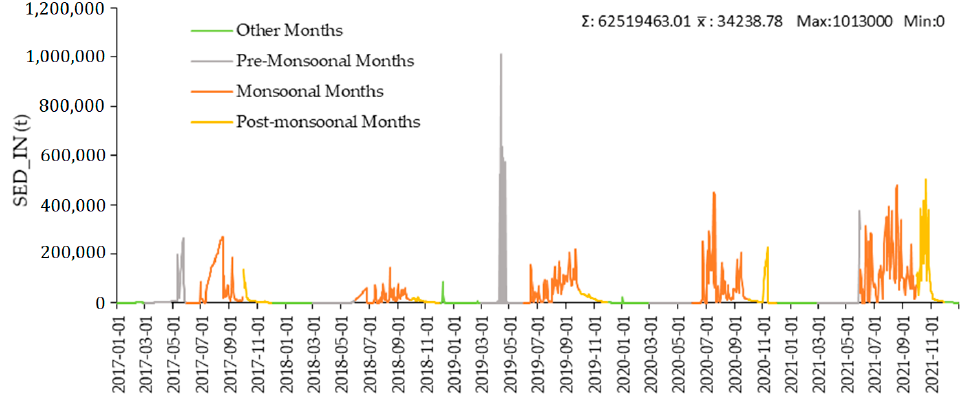
Figure 8. Simulated hydrographs displaying daily sediment influx (SED_IN) and its variations during pre-monsoon, monsoon, and post-monsoon.